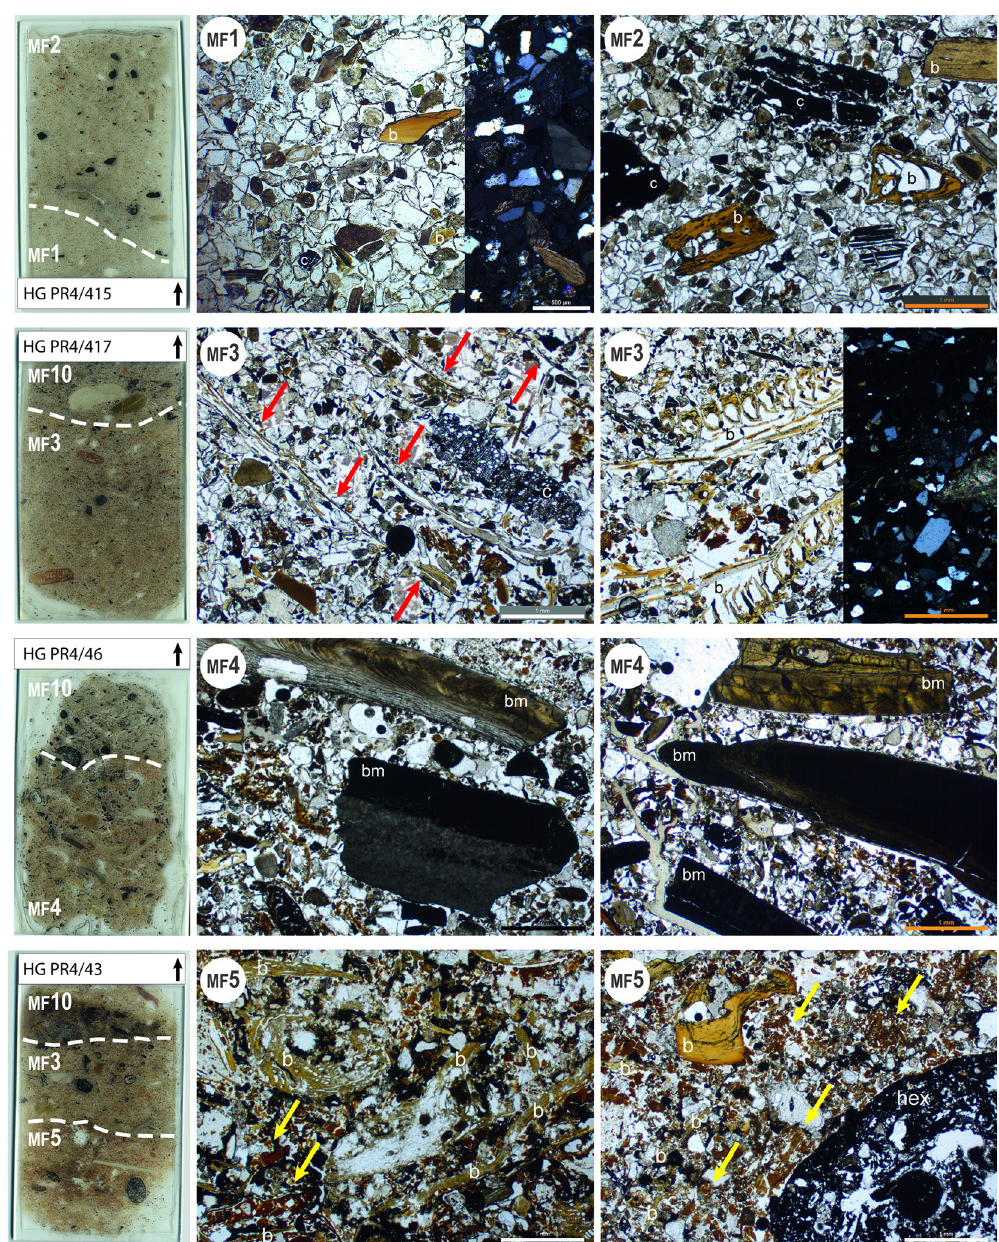
Fig 6. Scans and photomicrographs of thin-sections representing microfacies related to natural (MF1) and occupation (MF2 to MF5) deposits. All images are presented in PPL light. Only the MF1 image and the second of the MF3 images are presented in both PPL (right two thirds of the image) and XPL (left one third of the image). The dashed lines represent the borders between MFs in each thin-section. The main components of the coarse fraction are labelled: b = bones; c = charcoal; bm = burnt mollusc shells; hex = herbivore excrement. Red arrows in the first MF3 photo indicate parallel fishbones. In the second MF3 photo, fishbones are still in anatomical position. Yellow arrows in the MF5 photos indicate aggregates of organic matter, probably remains of fish flesh. Note the higher proportion of aeolian sands (mostly quartz and plagioclase grains) in MF1 and MF2 compared with MF3, MF4 and MF5.